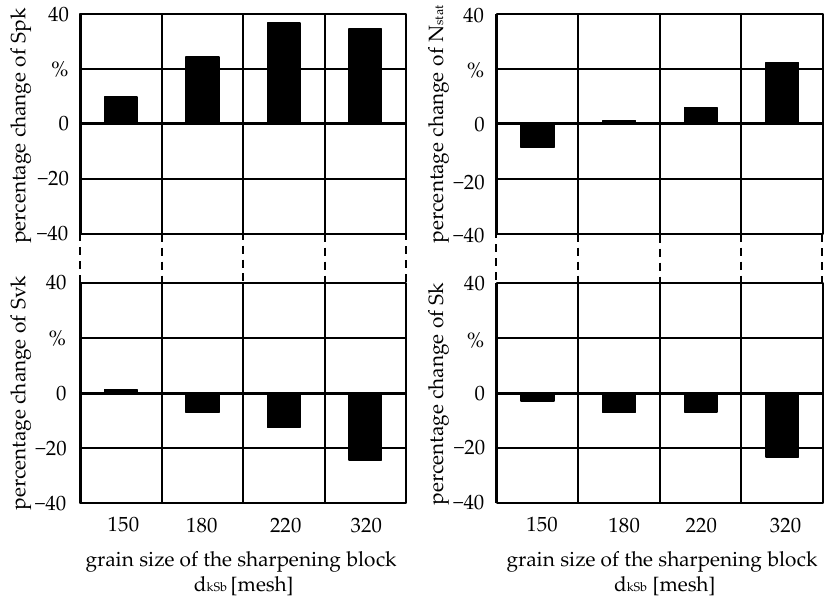
Figure 7. Influence of the grain size of the sharpening block d kSb on the topography characteristics.